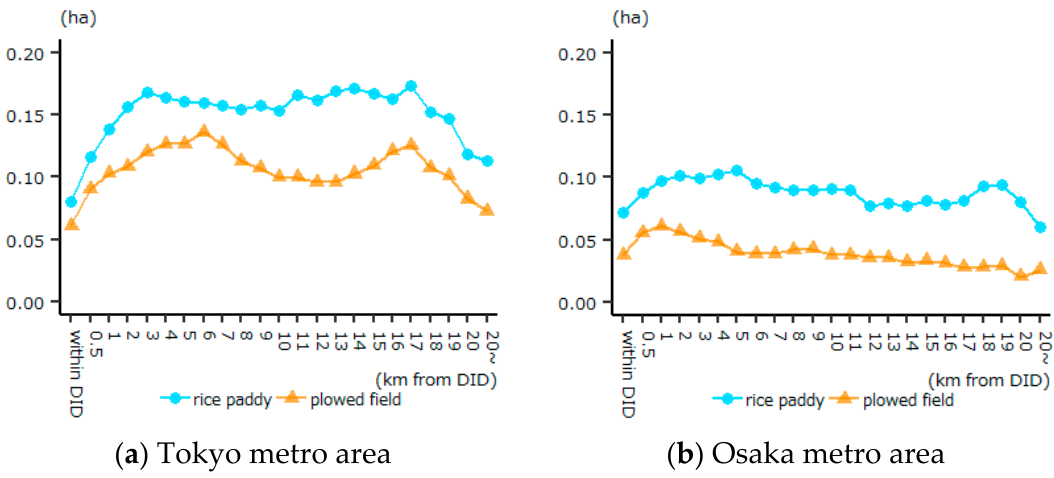
Figure 8. Average plot sizes by distance from DID. ( a ) shows the case of Tokyo metro area and ( b ) shows the case of Osaka metro area.